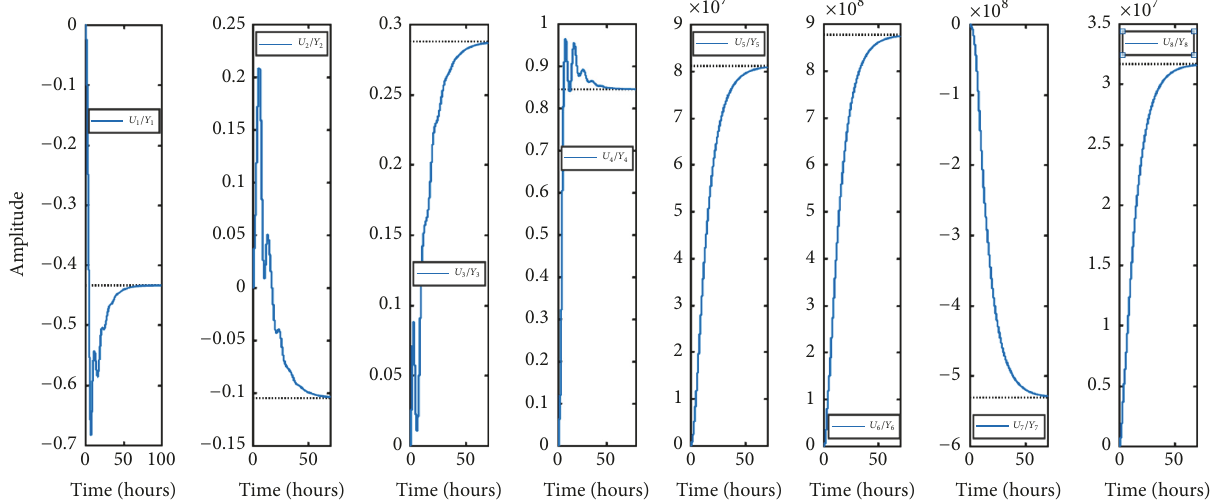
Figure 15: Steps response of the open loop system with sampling time of 3600 s.